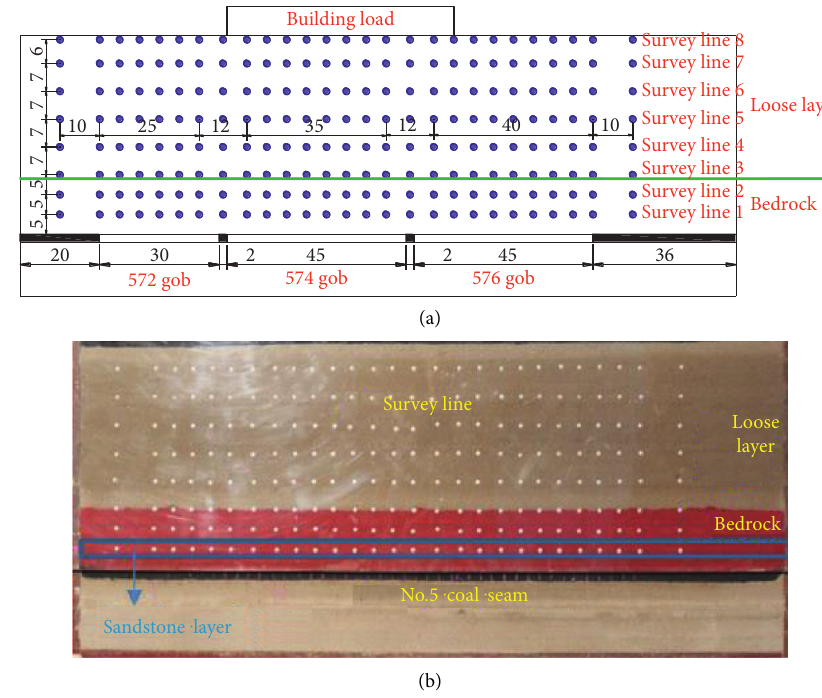
Figure 10: (a) Layout shape of the model; (b) actual shape of the model.